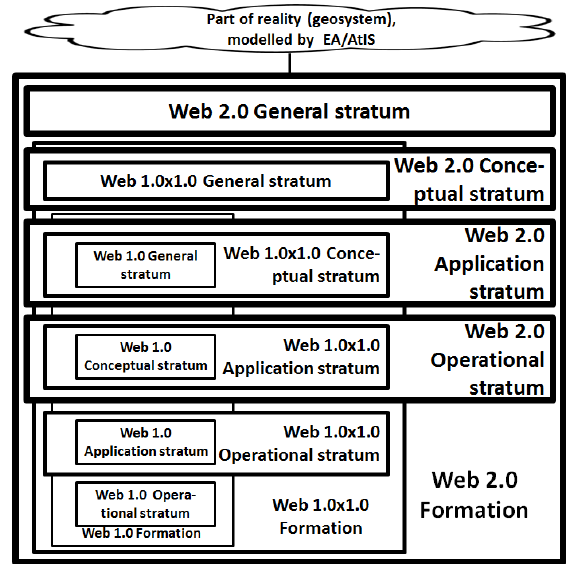
Figure 7. Other view of Formations-Strata projection of EA/AtIS